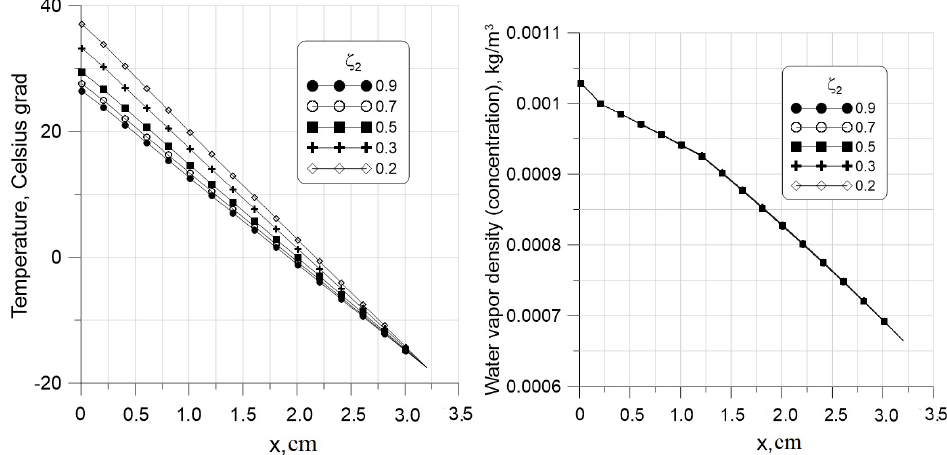
Figure 9. Influence of the IR on the temperature ( left ) and the vapor concentration ( right ) distribution across the garment after 120 min. Polyester batting thickness is 2.0 cm.